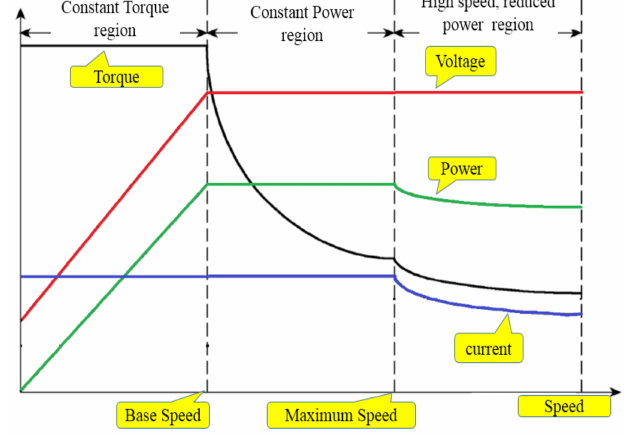
Figure 9. IM characteristics and variation of variables with